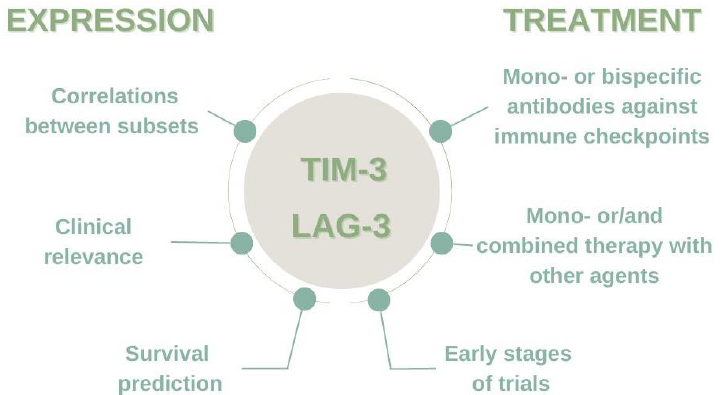
Figure 2. The importance of TIM-3 and LAG-3 expression in the microenvironment and immuno- therapy .